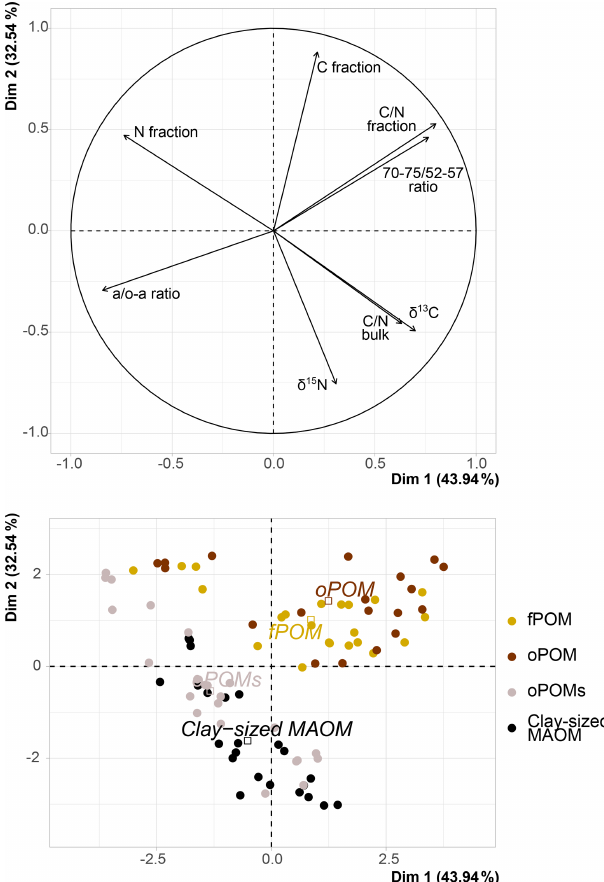
Figure 4. Natural abundance of δ 13 C and δ 15 N plotted against the C / N ratios and the δ 15 N values plotted against the N content of SOM fractions (free particulate OM – fPOM, occluded particulate OM – oPOM, small occluded particulate OM – oPOMs – and clay- sized mineral-associated OM – MAOM): the values of δ 13 C (‰ relative to V-PDB) (a) and the values of δ 15 N (‰ relative to air N 2 ) (b) in relation to the C / N ratio (log-converted) of SOM frac- tions and δ 15 N (‰ relative to air N 2 ) plotted against N content (in mgg − 1 ) of the SOM fractions (c) .